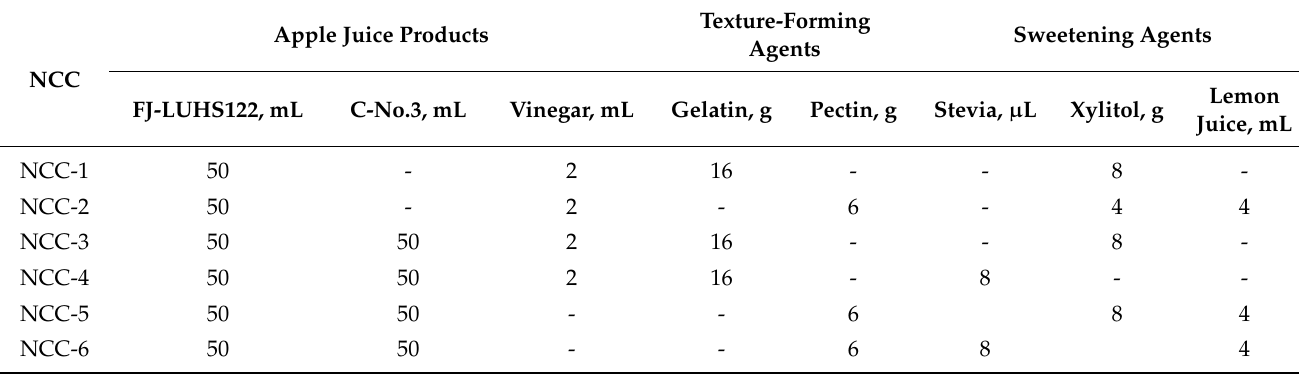
Table 1. Nutraceutical chewing candy